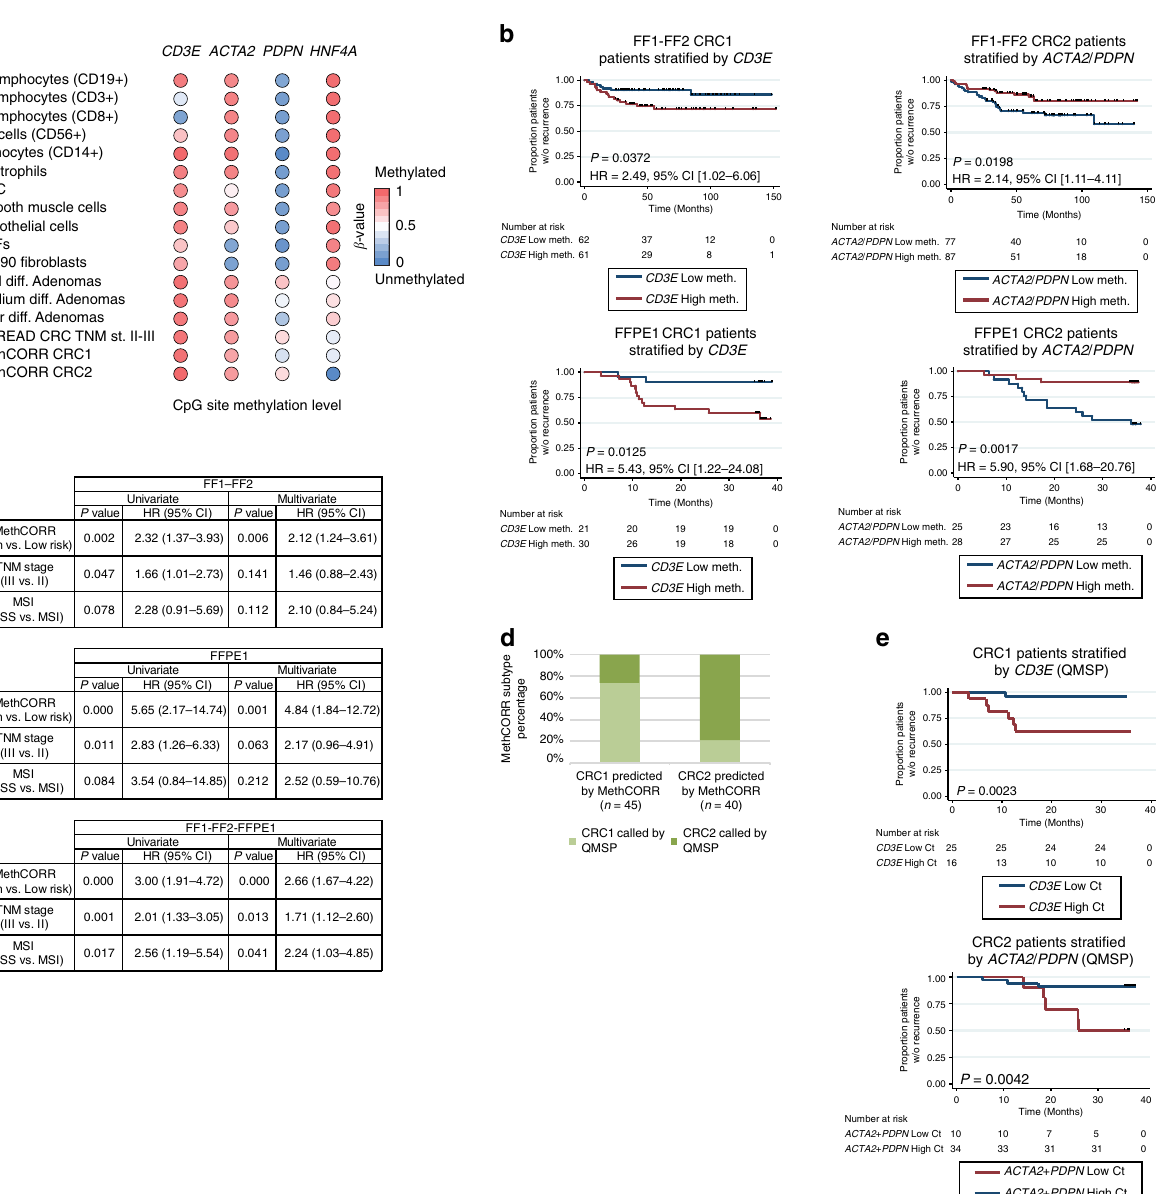
Fig. 5 Validation of subtype-speci fi c prognostic biomarkers in fresh-frozen and FFPE cohorts. a Dot plot showing the methylation levels ( β -values) of a CpG site in the promoter region of CD3E , ACTA2 , PDPN , and HNF4A in selected cell types, adenomas and CRC samples as evaluated by the In fi nium HumanMethylation450 BeadChip array. High and low methylation levels are indicated in red and blue colors, respectively. See Supplementary Data 13 for details of included cell types such as mesenchymal stromal/stem cells (MSCs), natural killer (NK) cells, and cancer-associated fi broblasts (CAFs). b Kaplan – Meier plot showing the relapse-free survival of patients strati fi ed by the CpG methylation level of the CD3E promoter in CRC1 and by the average CpG methylation level of the ACTA2 / PDPN promoter in CRC2 of the combined FF1-FF2- and the FFPE1 cohorts. P values (log-rank test) and HR95% CI are indicated. The same β -value cutoff was used in both cohorts (different cutoff for the subtype-speci fi c biomarkers). c Table showing an uni- and multivariate cox regression analysis with MethCORR high and low relapse risk groups (a high relapse risk group was samples with high CD3E methylation levels in CRC1 or low average ACTA2 / PDPN methylation levels in CRC2), TNM stage, and MSI status in the combined FF1 – FF2 cohort, the FFPE1 cohort, and all cohorts combined. d Histogram showing the overlap in CRC1 and CRC2 status prediction by NMF clustering using MCSs or by QMSP in FFPE samples from the FFPE1 cohort. e Kaplan – Meier plot showing the relapse-free survival of CRC1 patients strati fi ed by CD3E QMSP assay Δ Ct values and in CRC2 by ACTA2 / PDPN QMSP Δ Ct-values in a total of 85 FFPE samples from the FFPE1 cohort. P values (log-rank test) and HR95% CI are